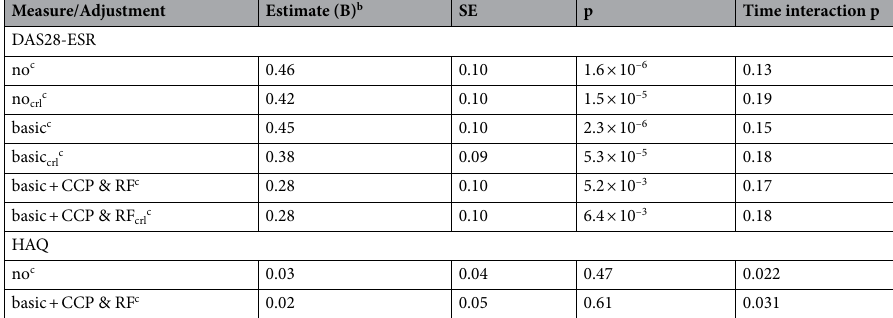
Table 6. Association of the DAS28-ESR and HAQ with ACarPA using all available follow-up data a . a Analyzed with mixed effects pattern mixture models including all available follow-up data for DAS28-ESR or HAQ, respectively. b The estimated (B) overall increase in the activity measure in ACarPA + relative to ACarPA − patients, its standard error (SE) and p value are presented, as well as, the p values for the ACarPA status interaction with time. c The analyses were performed as in Table 2 except when controlled ( crl ) by the inclusion of the two patterns showing MNAR